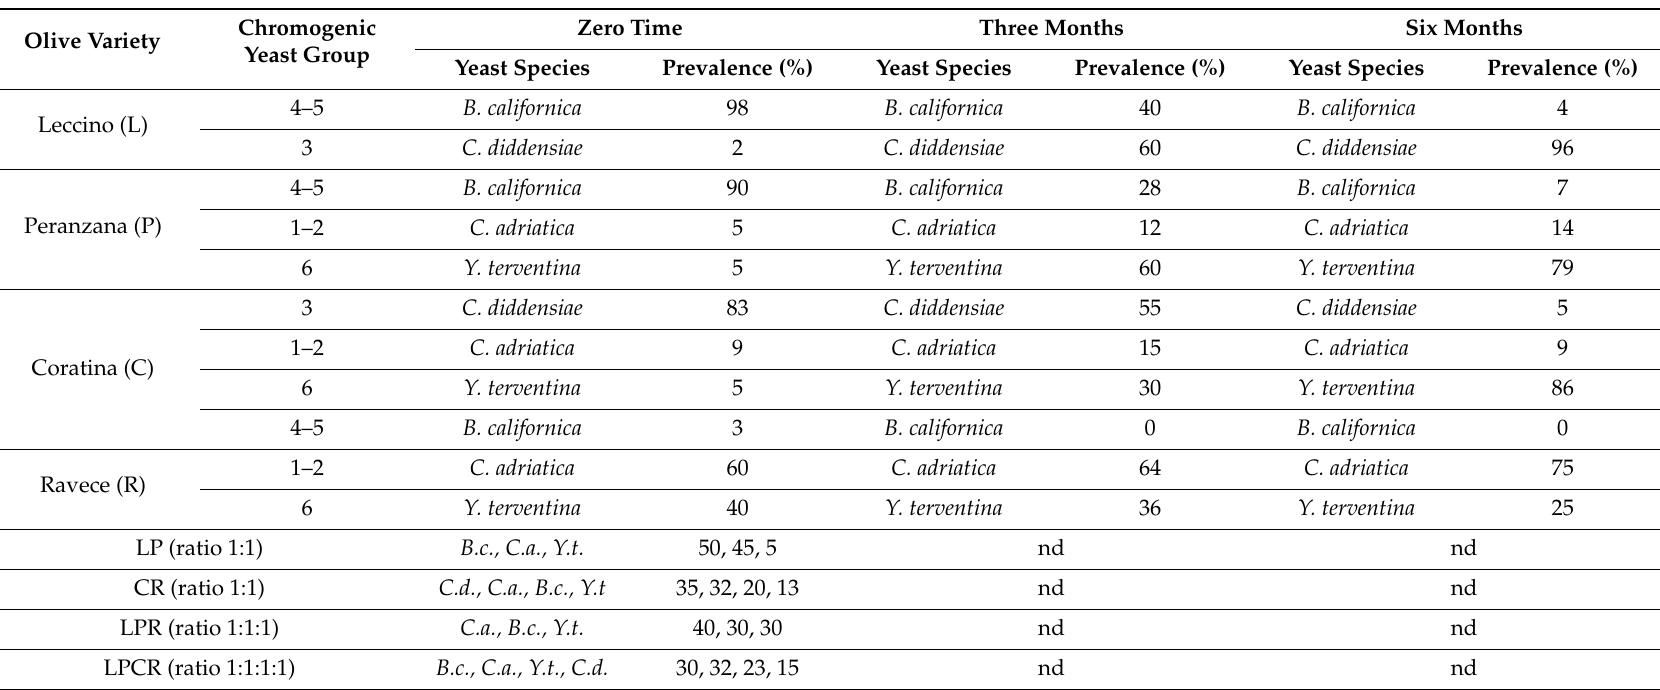
Table 4. Dynamic of yeast species populations in monovarietal and blended extra virgin olive oils (EVOOs) during storage. Chromogenic Olive Variety